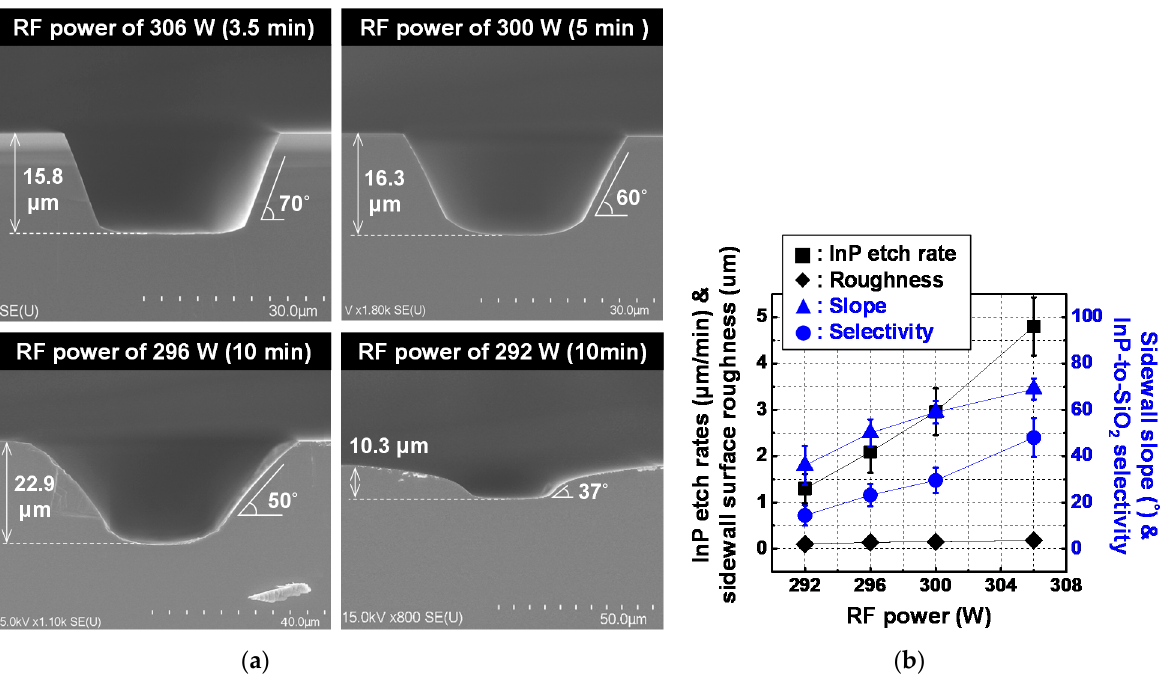
Figure 9. Fabrication results of InP via holes etched at different levels of RF power using a wet-etched SiO 2 layer as an etch mask for InP dry etch: ( a ) SEM images of representative etch profiles and ( b ) InP etch rate, sidewall surface roughness, sidewall slope and InP-to-SiO 2 selectivity of InP via holes. Error bars in Figure 9b represent the deviation value incurred by process variation for a total of 60 InP via holes with the identical layout pattern in the three fabrication lots. ICP power, Cl 2 /Ar gas mixture, operation pressure, and operation temperature of the ICP etcher were 1200 W, 18/17 sccm, 5 mT, and room temperature, respectively. Table 2. Footprint comparison of fabricated InP via holes with various sidewall slopes.